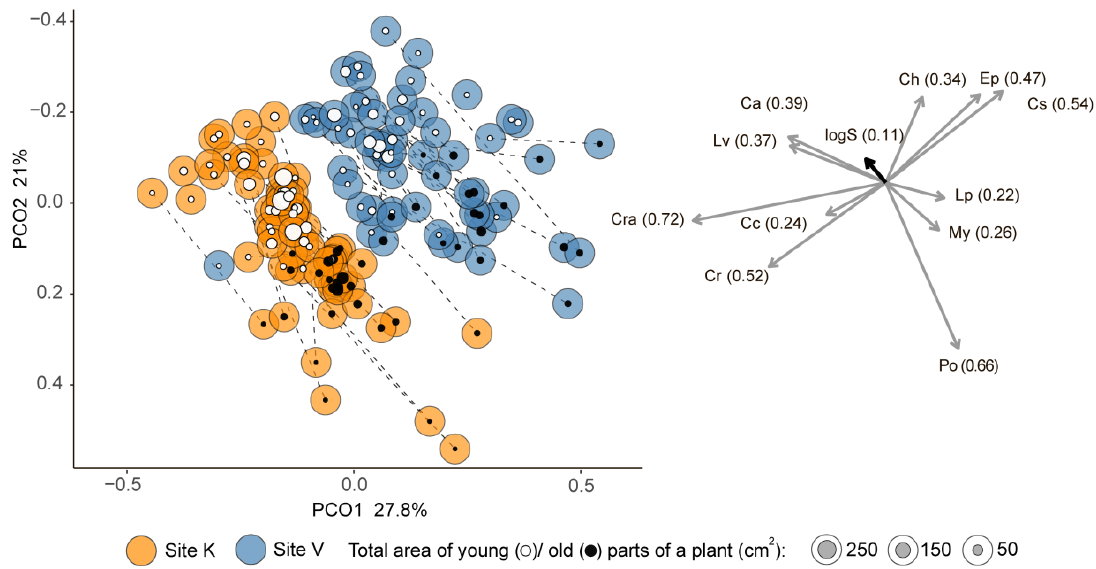
Figure 2. Principal coordinates ordination (PCO) of sessile species percent covers on young and old parts of Phycodrys rubens in September 2015. Bray-Curtis similarity on fourth root transformed data. Dashed lines connect young and old parts of a single plant in those having both. Species with R 2 (in brackets) > 0.2: Po—Porifera; My—juvenile Mytilidae ( Musculus discors and Modiolus modiolus